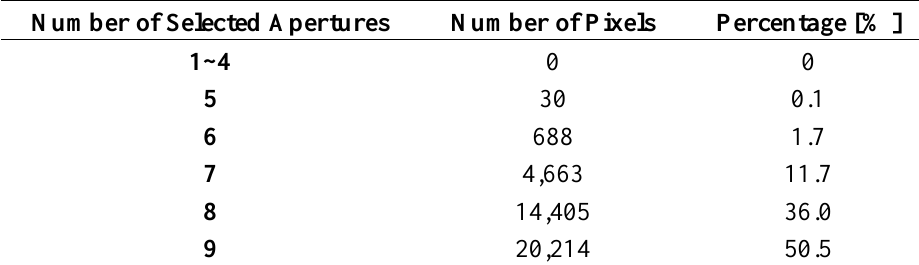
Table 1. Number of pixels in each number of selected